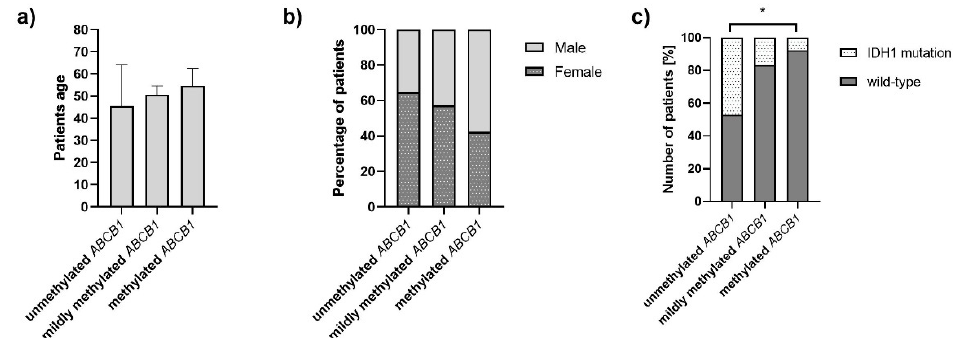
Figure 7. Bar charts presenting the distribution of ABCB1 methylation among glioma patients of ( a ) different age, ( b ) sex, and ( c ) IDH1 mutation status. Statistically significant difference is indicated with the asterics (*).